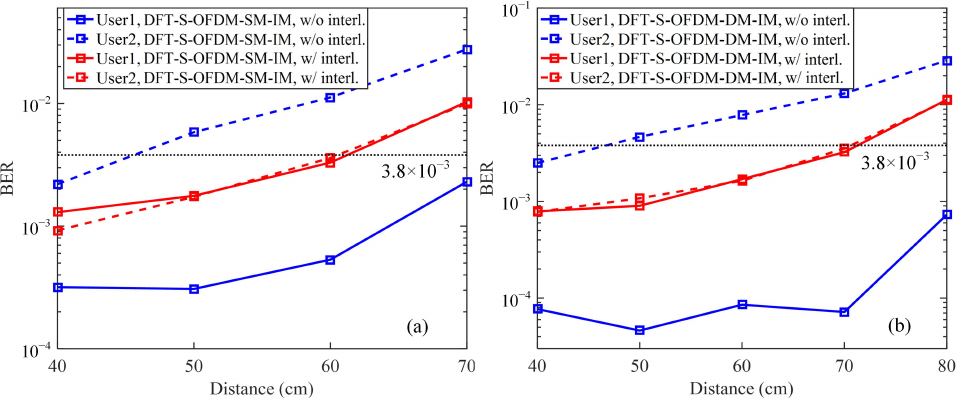
Figure 8. Measured BER vs. distance for ( a ) DFT-S-OFDM-SM-IM without and with interleaving and ( b ) DFT-S-OFDM-DM-IM without and with interleaving (w/o: without, w/: with, interl.: